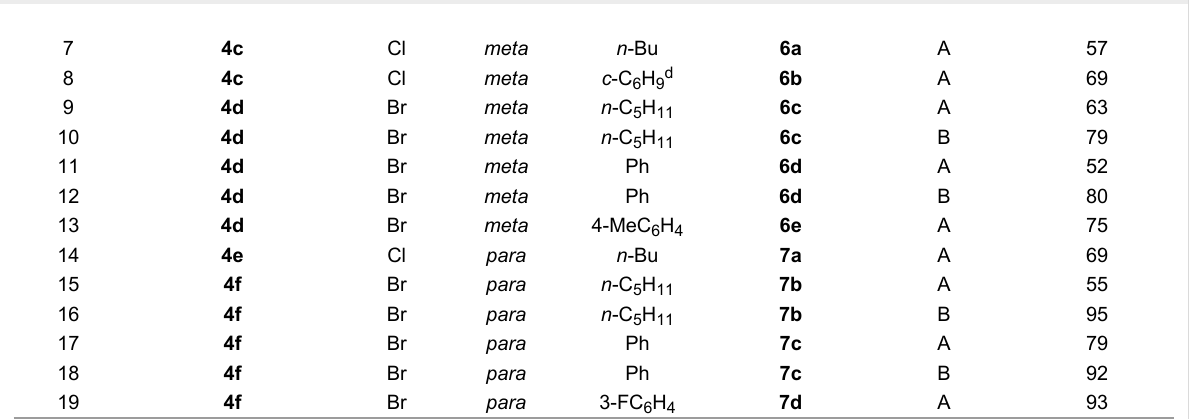
Table 2: Synthesis of dimethoxy-substituted o -alkynylhaloarenes 5 – 7 .